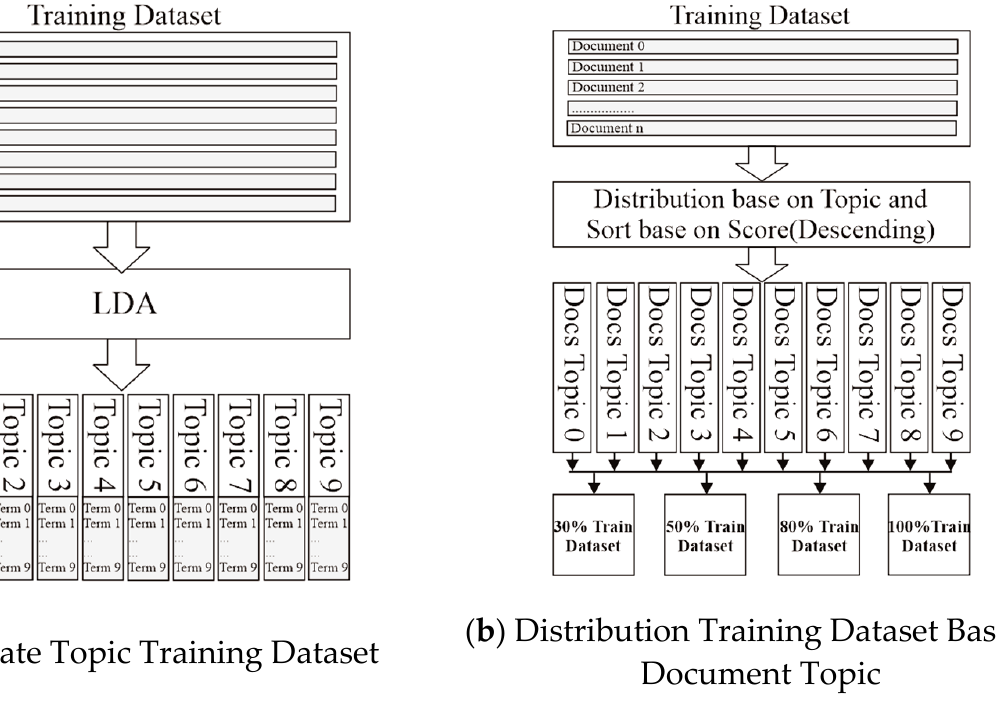
Figure 2. ( a ) The generate process diagram aims to produce topics using documents from the training dataset. ( b ) Using the same LDA model in Figure 1, the system will distribute documents in the dataset based on topic and sort documents based on scores in descending order.